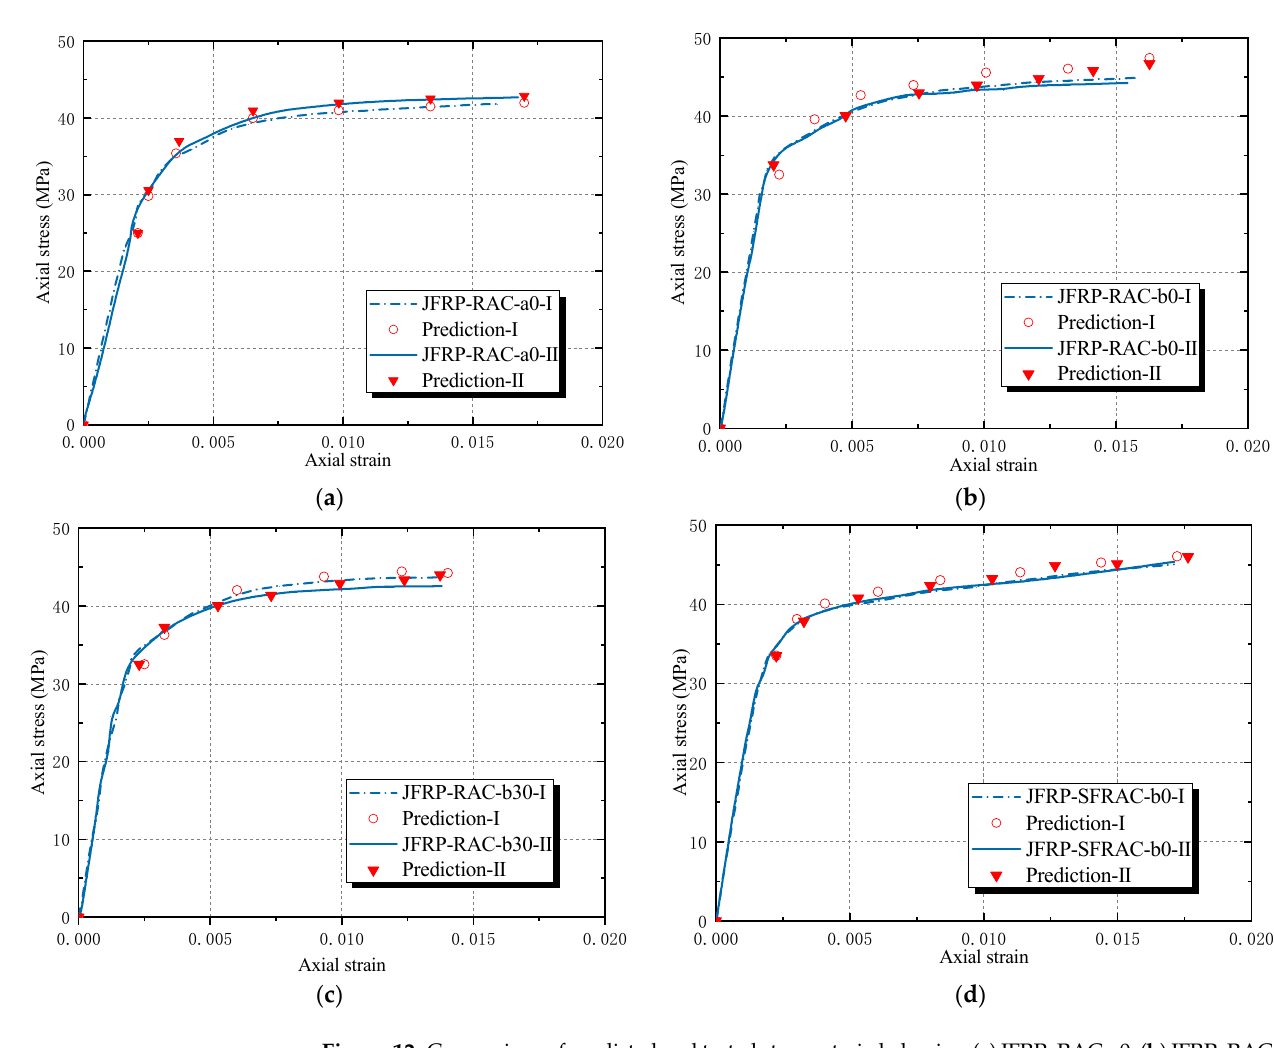
Figure 12. Comparison of predicted and tested stress–strain behavior: ( a ) JFRP–RAC-a0, ( b ) JFRP–RAC-b0, ( c ) JFRP–RAC-b30 and ( d ) JFRP–SFRAC-b0.